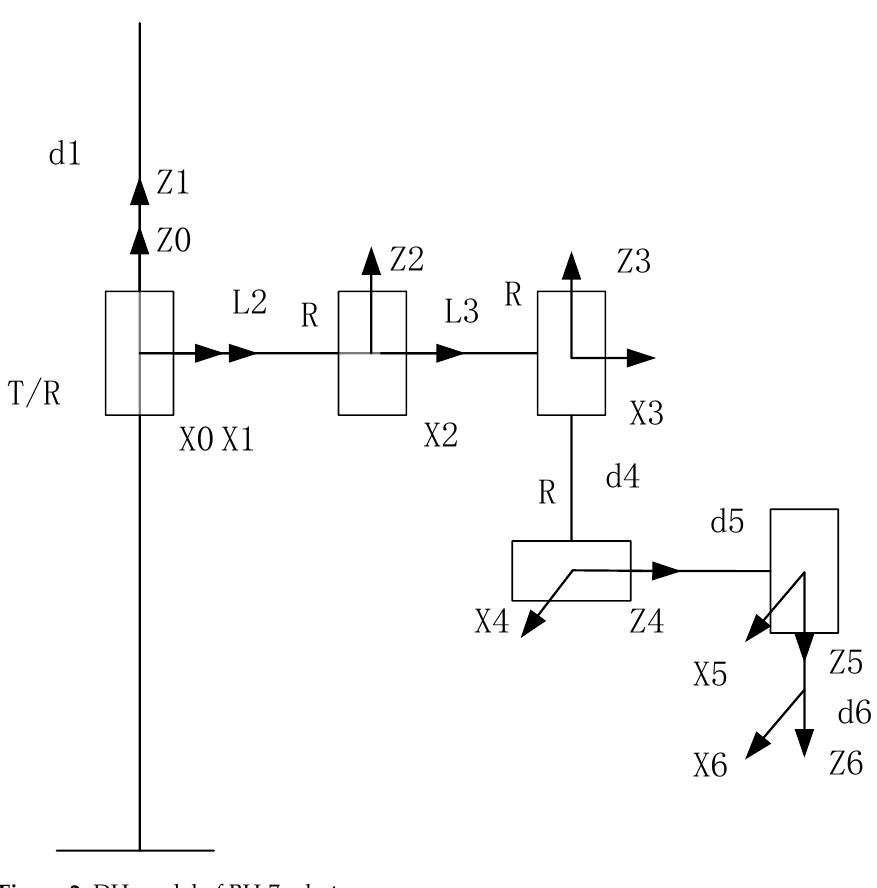
Figure 2. DH model of BH-7 robot.